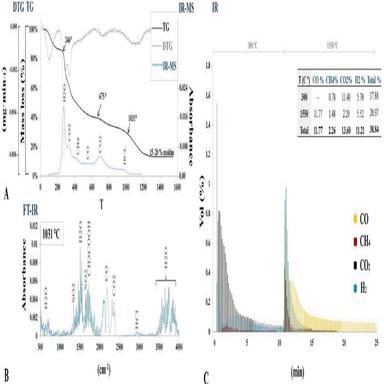
A) TG-DTG thermograms of nonisothermal pyrolysis of the Kelp raw powder under N2 purge, including IR-MS intensity profile of simultaneous gas analysis. B) FT-IR absorbance spectra of the evolved gases taking place at T = 1031 ◦C). C) Evolved gas analysis indicating cumulative production rate of CO, CH4, CO2, and H2 gas species under Ar purge at 300 ◦C and 1550 ◦C.